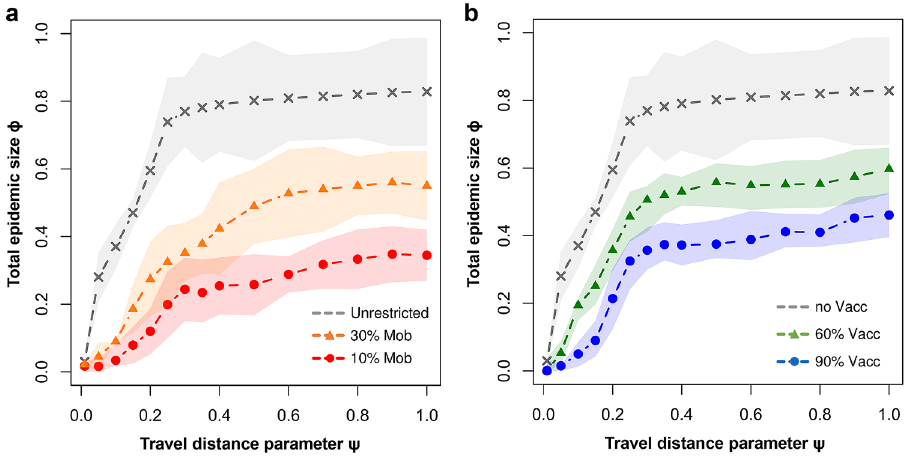
Figure 5. Total epidemic size φ , averaged over 2000 simulations, as a function of the travel distance parameter (cid:31) in two complementary scenarios. ( a ) Epidemic size in response to a mobility reduction down to 30% (orange), respectively 10% (red). ( b ) Epidemic size in response to adopting a linear immunization policy of vaccinating 60% (green), respectively 90% (blue) of individuals per year of simulation (i.e., 365 iterations). Colored regions indicate 95%